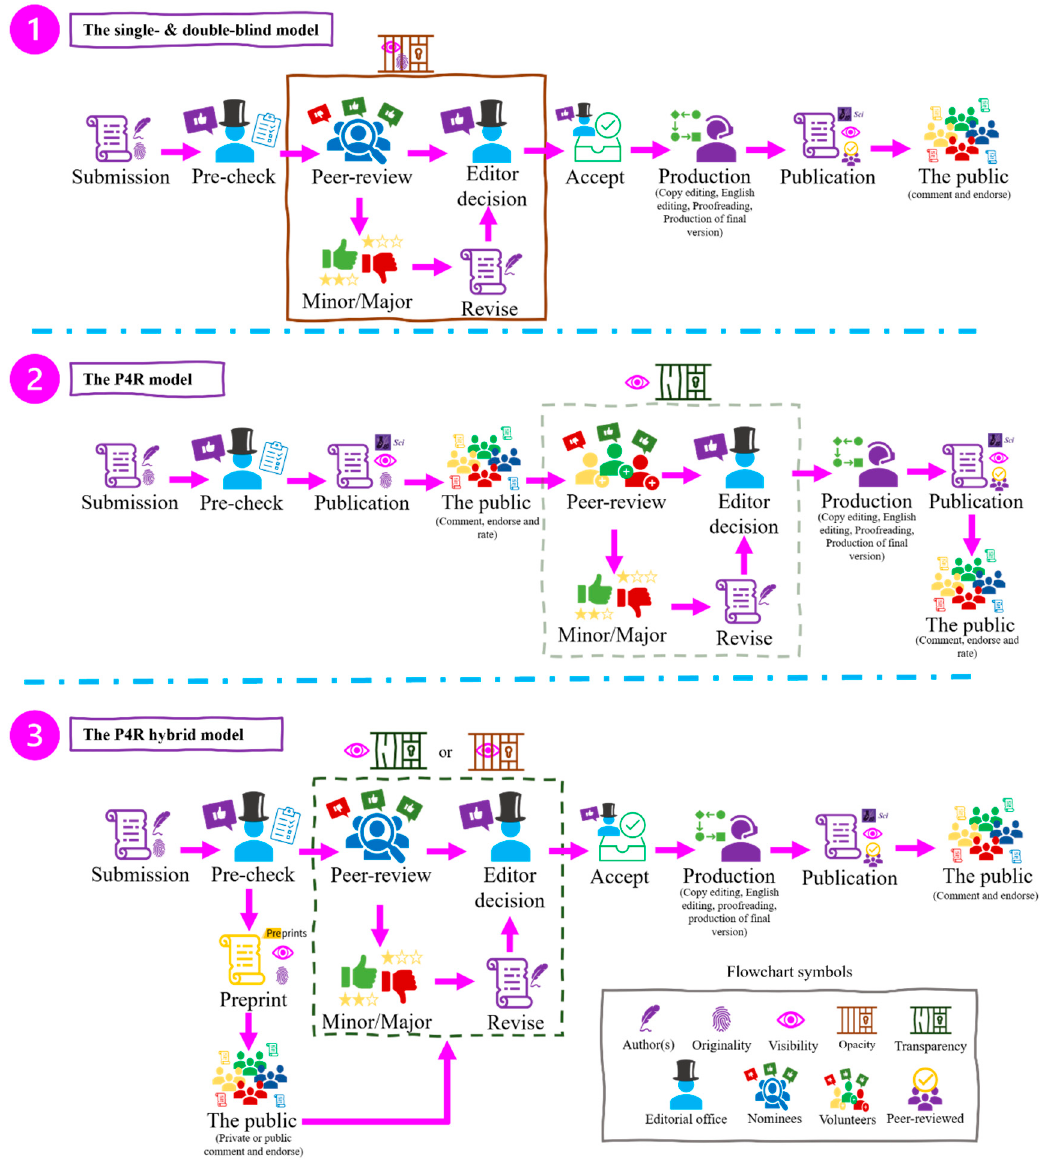
Figure 1. The three panels represent the workflows of the single- and double-blind, P4R and P4R hybrid models, respectively. The panels illustrate the differences in the peer review processes from submission to final decision in terms of transparency, preserving originality, visibility and community engagement. (adopted, with permission, from [3]).